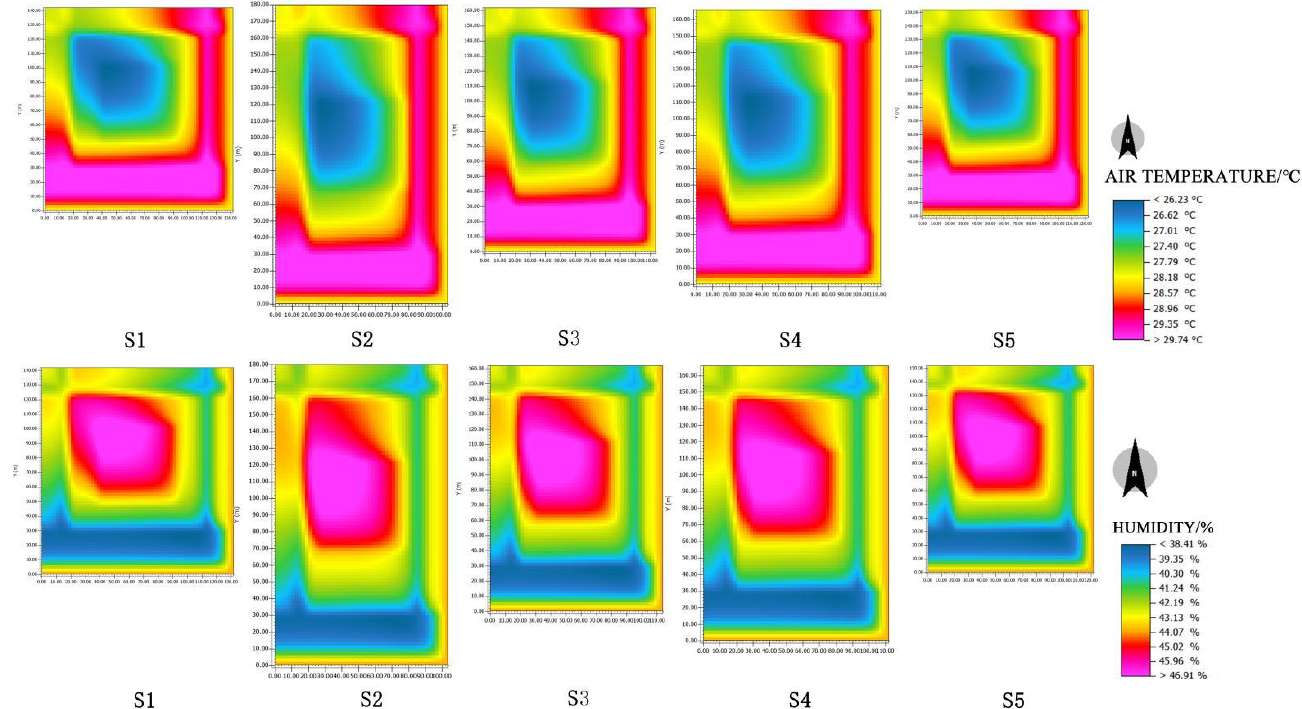
Figure 18. Temperature and humidity plane distribution of each square scheme.